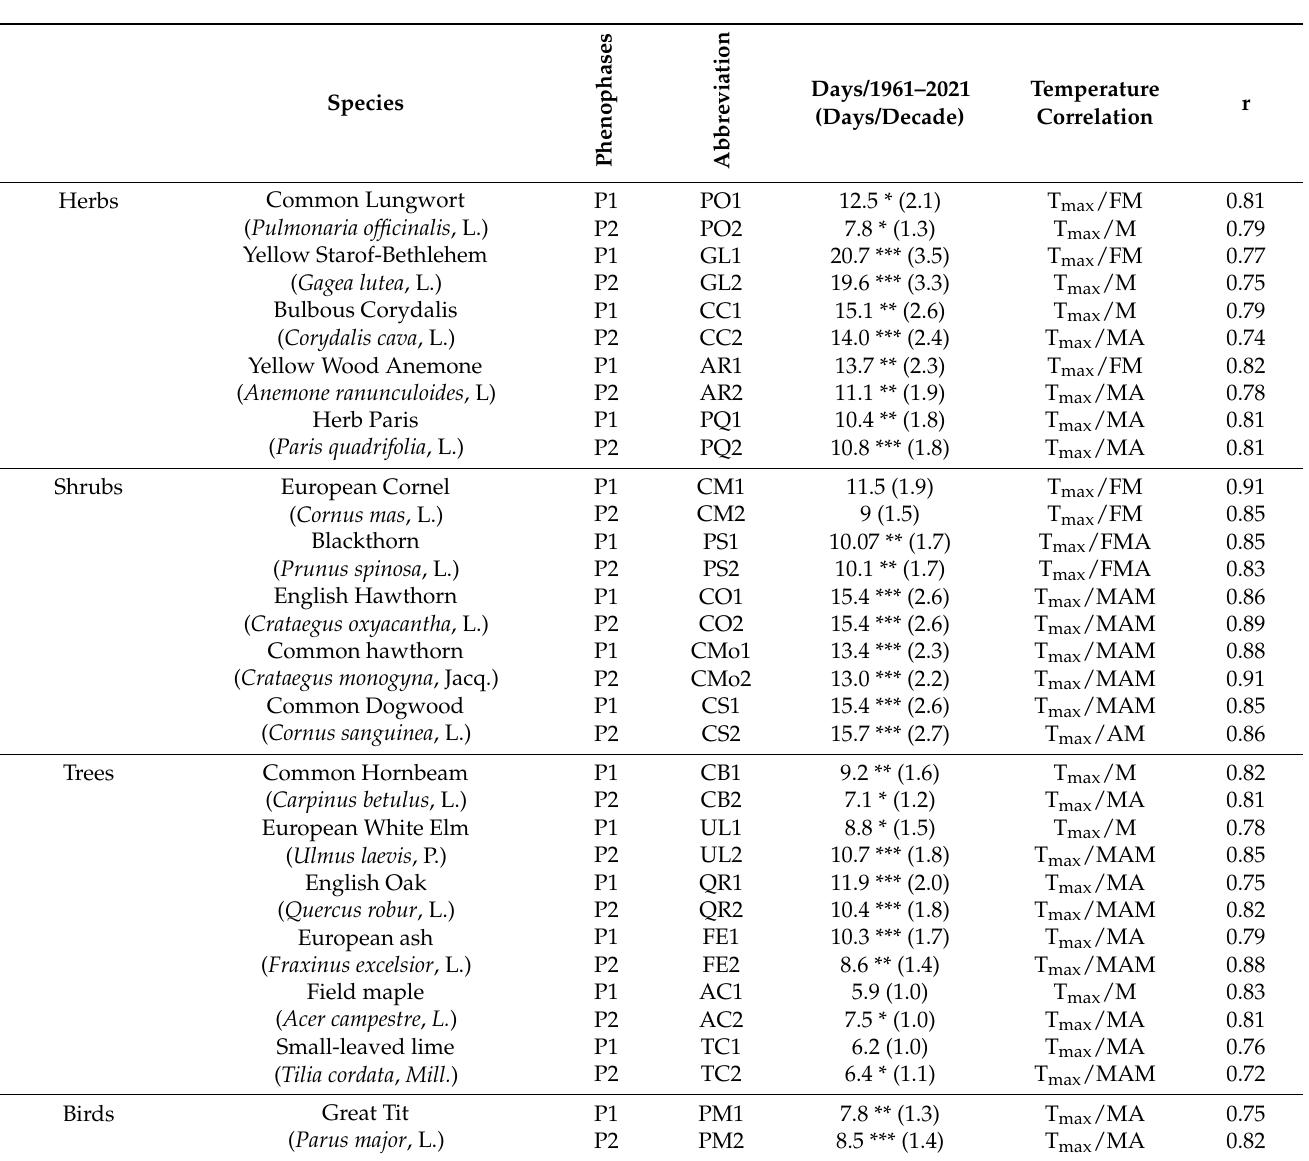
Table 2. Linear trends for observed phenological terms (slope of the linear regression line). P1 indicates phenophase ‘first flower’ for herbs and shrubs; bud breaking for trees and FLD (first laying date) for bird species. P2 indicates phenophase ‘full flowering’ for herbs and shrubs; full foliage for trees and MLD (mean laying date) for bird species. Correlation with maximum air temperature (T max ) was detected for averaged values of months: FM (av. temperature for February and March), M (av. temp. for March), MA (av. temp. for March and April), FMA (av. temp. for February, March, and April) and MAM (average temperature for March, April, and May). The value “r” (correlation coefficient) describes the relationship among terms of phenophases and T max (all coefficients are significant at α =